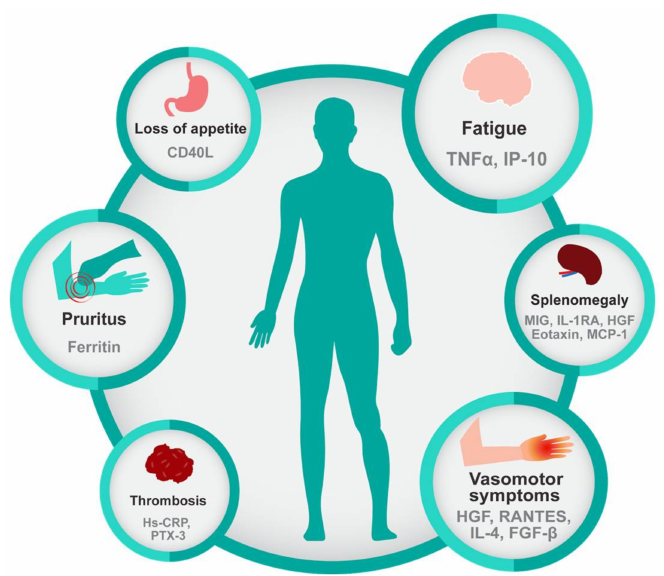
Figure 2. Inflammatory cytokines are correlated with characteristic features of myeloid malignancies. Common symptoms of myeloid malignancies, especially of primary myelofibrosis, include fatigue, pruritus, loss of appetite, and vasomotor symptoms and are significantly correlated with inflammatory biomarkers. Splenomegaly, which is inherent to the biology of MPN is also associated with increased inflammatory cytokines as is thrombosis a common complication of MPN. Referenced in